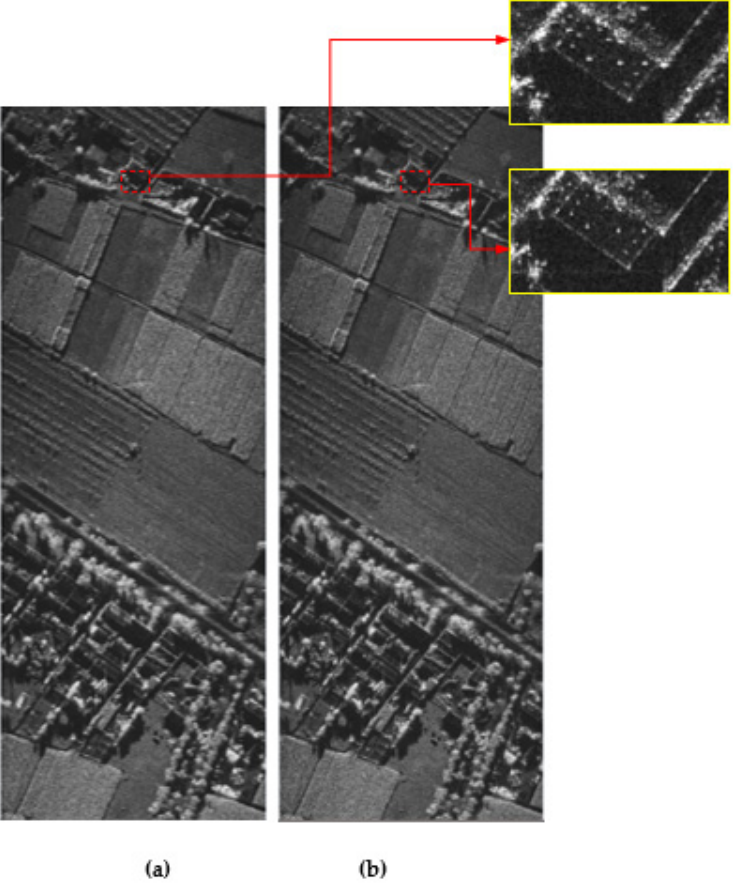
Figure 10. Experimental results. ( a ) CPFA; ( b ) EPFA.